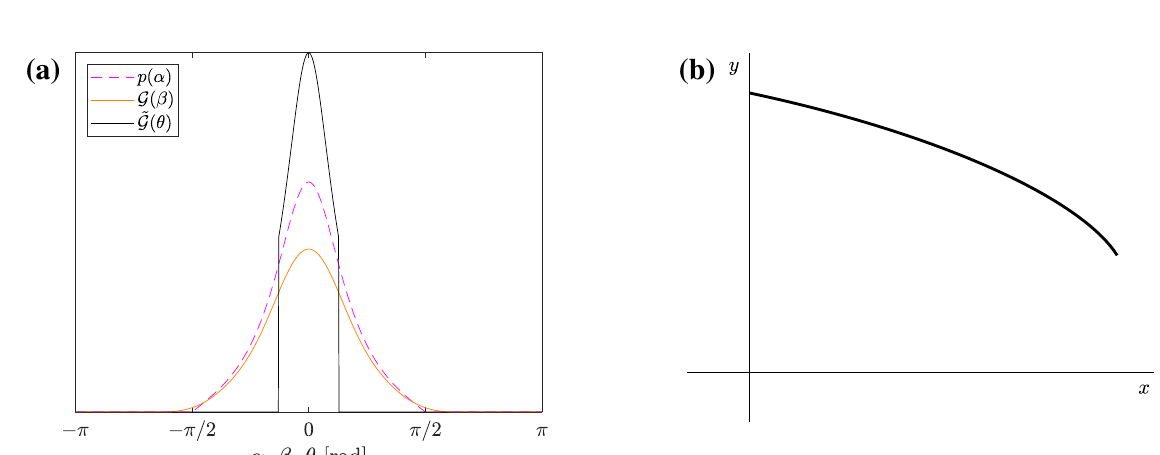
Figure 2. Two-dimensional example of reflector design using the proposed method; (a) the given intensity distribution G ( β ) and the spreading density function p ( α ) are deconvolved to get ˜ G ( θ ); (b) the corresponding specular reflector yielding ˜ G ( θ ) in the far field when I ( t ) is taken to be unity for all relevant values of t